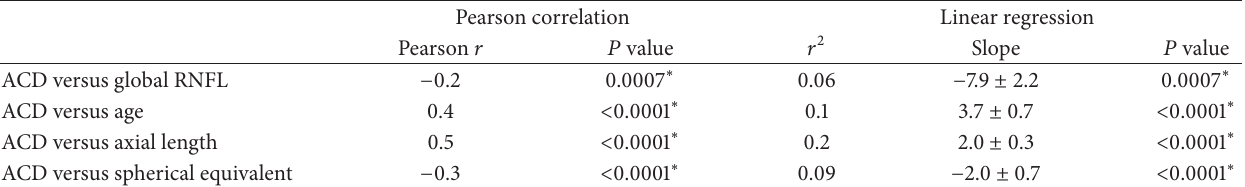
Table 2: Correlation between anterior chamber depth and global retinal nerve fiber layer, age, axial length, and spherical equivalent. Pearson correlation Linear regression